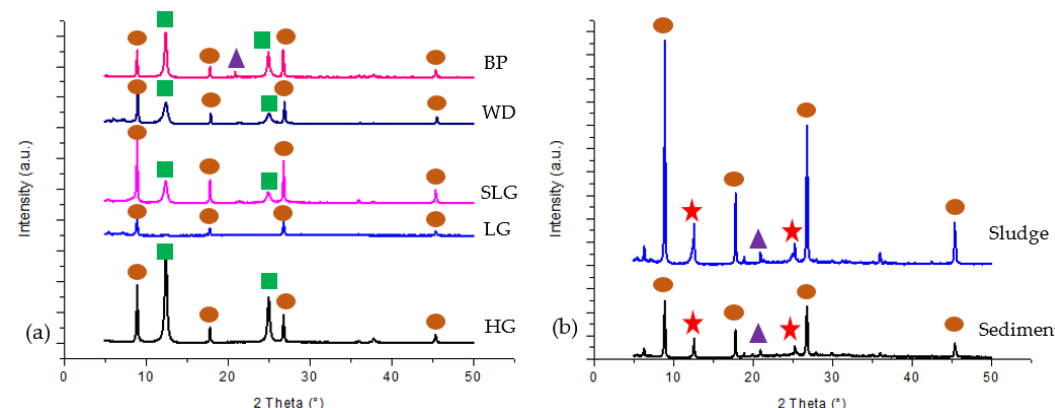
Figure 3. X-ray diffractograms of the soil clay fraction from the: ( a ) stockpile (HG, LG, SLG), waste dump (WD), borrow pit (BP); and ( b ) sludge and sediment from mine tailings. The added symbols signify the peaks for all types of mining wastes: illite (orange circle), kaolinite (green square), chlorite-serpentine (red star) and quartz (purple triangle).